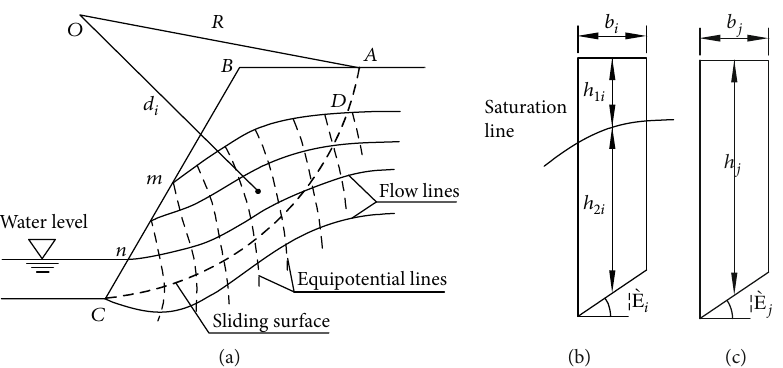
Figure 2: A concept glacio fl uvial deposit slope partially submerged in water: (a) a slope with seepage fi eld, (b) a slice extracted from the slope DC, and (c) a slice extracted from the slope DA.